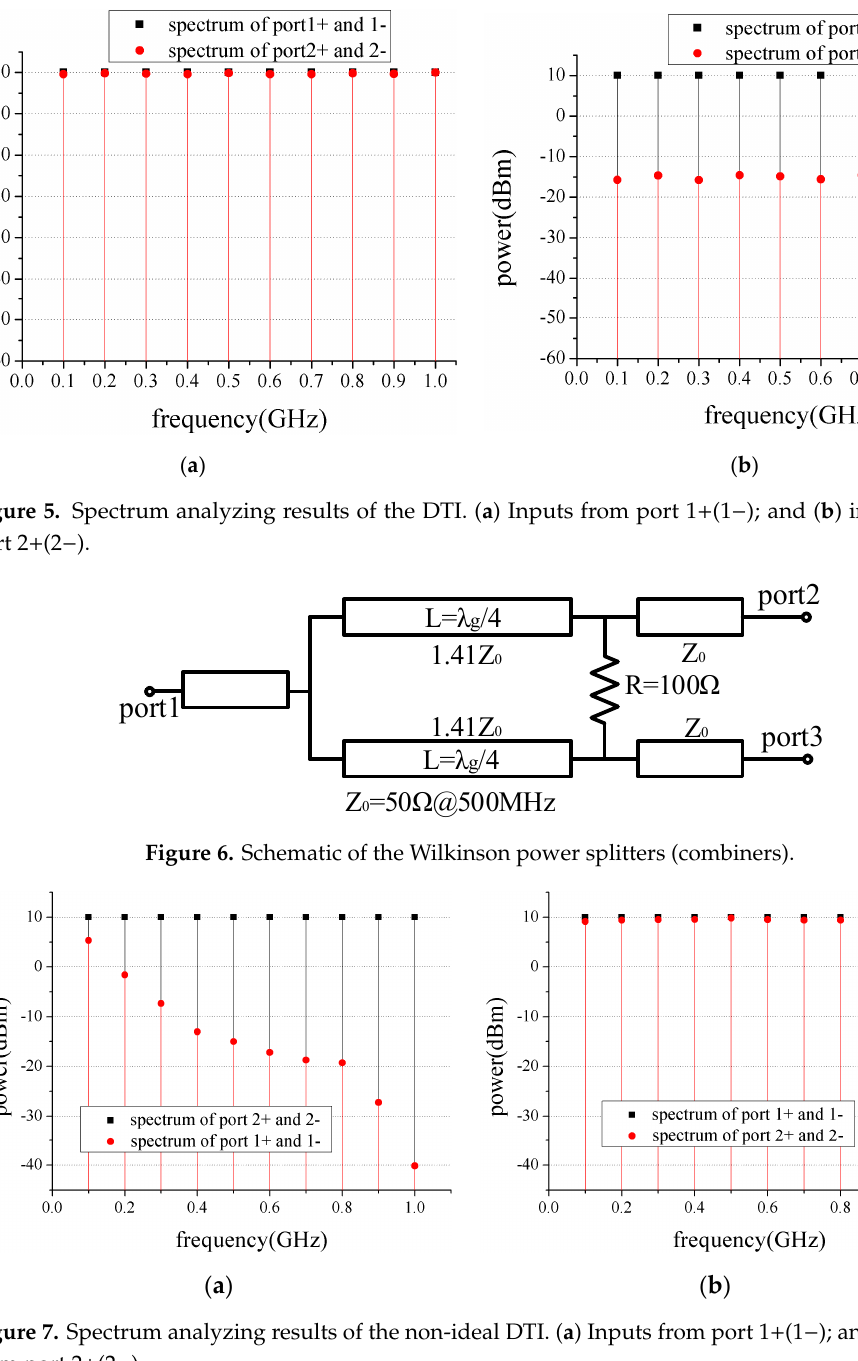
Figure 7. Spectrum analyzing results of the non-ideal DTI. ( a ) Inputs from port 1 + (1 − ); and ( b ) input from port 2 + (2 − ).